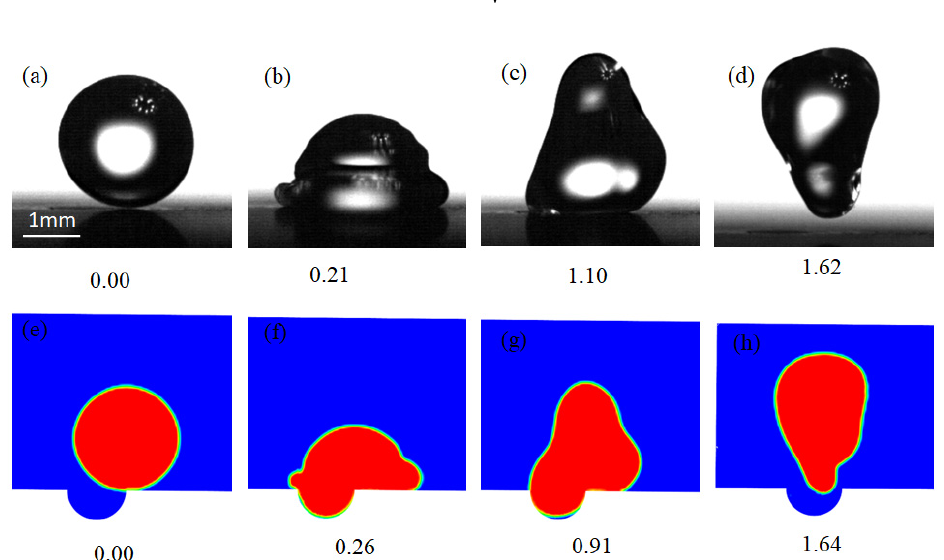
Figure 5. The validation of the simulation model. ( a – d ) Experimental results of a droplet impacting a dimpled surface with the normalized time of 0.00, 0.21,1.10 and 1.62, respectively. ( e – h ) Simulation of a droplet impacting a dimpled surface with the normalized time of 0.00, 0.26, 0.91 and 1.64, respectively.